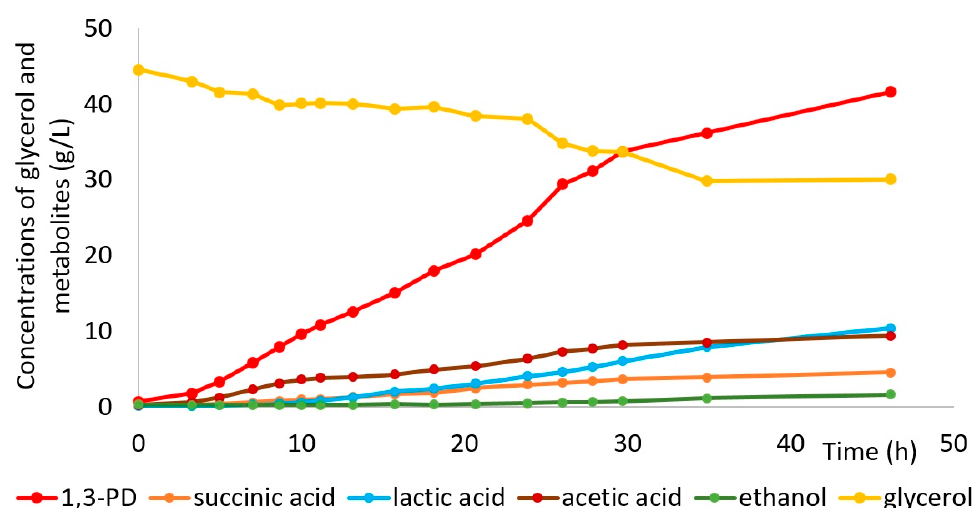
Figure 8. Concentration changes of glycerol and metabolites with respect to fermentation time. The ability to ferment glycerol to 1,3-PD is a known feat among C. freundii strains. The actual efficiency of this process is, however, dependent on the capacity of the strain itself and the process conditions, which include medium composition. Over the years, many studies of this bioconversion process have been performed in batch, fed-batch, immobilized, and continuous cultures (Table 7). A fed-batch fermentation using C. freundii FMCC-B 294 (VK-19) that yielded 68.1 g/L 1,3-PD was reported, proving the potential of this species. Our result, 41.7 g/L of 1,3-PD in fed-batch culture, indicates that further studies, including the optimization of culture conditions, may lead to improved production of 1,3-PD by C. freundii AD119. Table 7. 1,3-PD production by C. freundii dependent on types of culture and